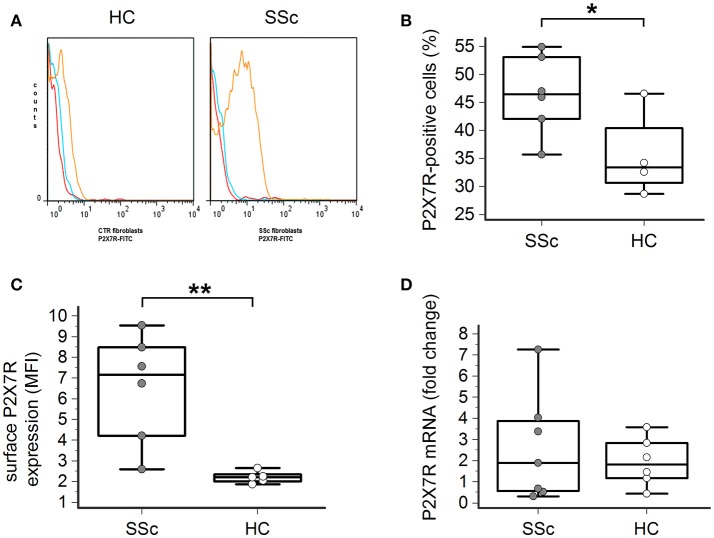
P2X7R surface expression is increased in SSc dermal fibroblasts. (A–C) P2X7R surface expression in dermal fibroblasts from SSc patients and HC, as determined by flow cytometry: (A) original flow cytometry data representative of an experiment; (B) percentage of P2X7R positive cells, and (C) MFI values. SSc patients, n = 6; HC, n = 5. *p < 0.05, two-tailed unpaired t-test; **p < 0.01, two-tailed Mann–Whitney test. (D) P2X7R mRNA expression in dermal fibroblasts from SSc patients and HC, as determined by quantitative RT-PCR analysis. SSc patients, n = 7; HC, n = 6. p = not significant, two-tailed unpaired t-test. SSc, Systemic sclerosis; HC, healthy controls; P2X7R, P2X7 receptor; MFI, mean fluorescence intensity; RT-PCR, reverse transcription-polymerase chain reaction.